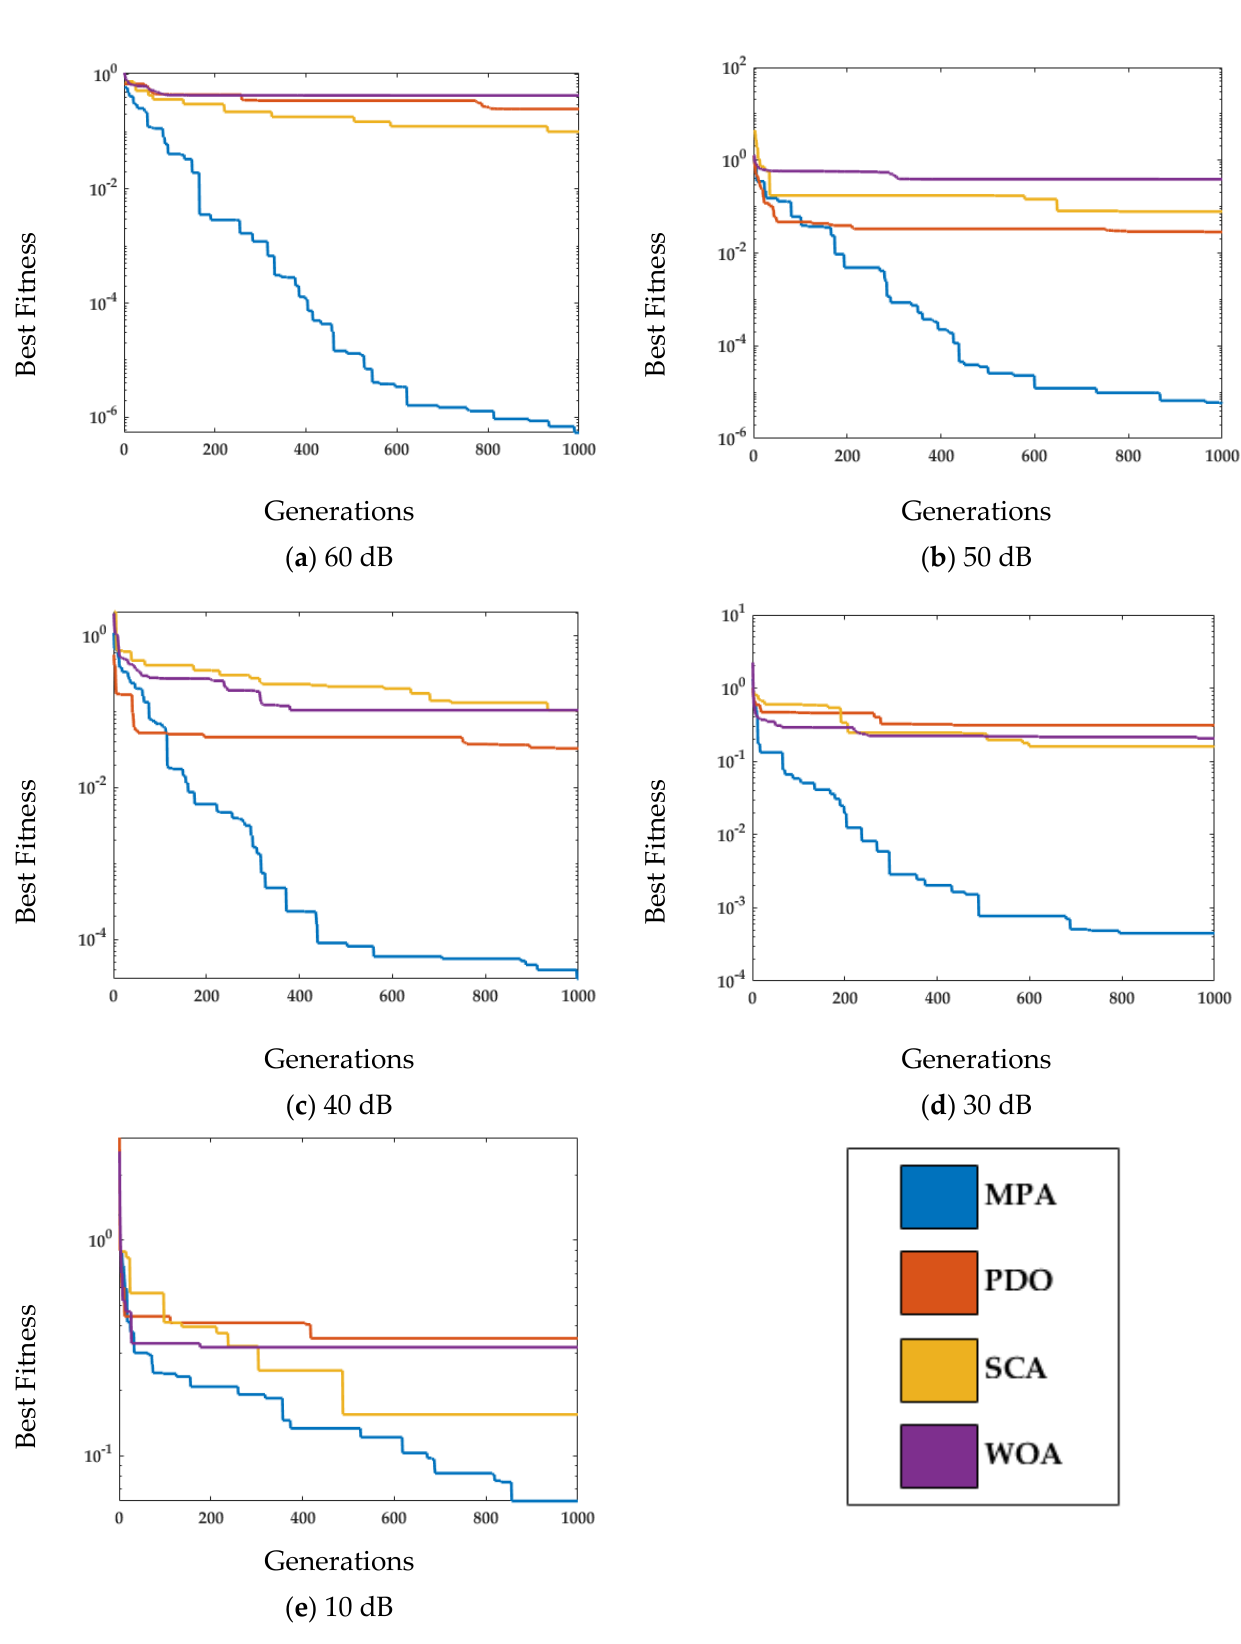
Figure 5. Fitness plot comparison of MPA with PDO, SCA, and WOA at Np = 100 and T = 1000 for case study 1. Table 2. Estimated weight analysis w.r.t generation and population sizes at 60 dB noise for case study 1.